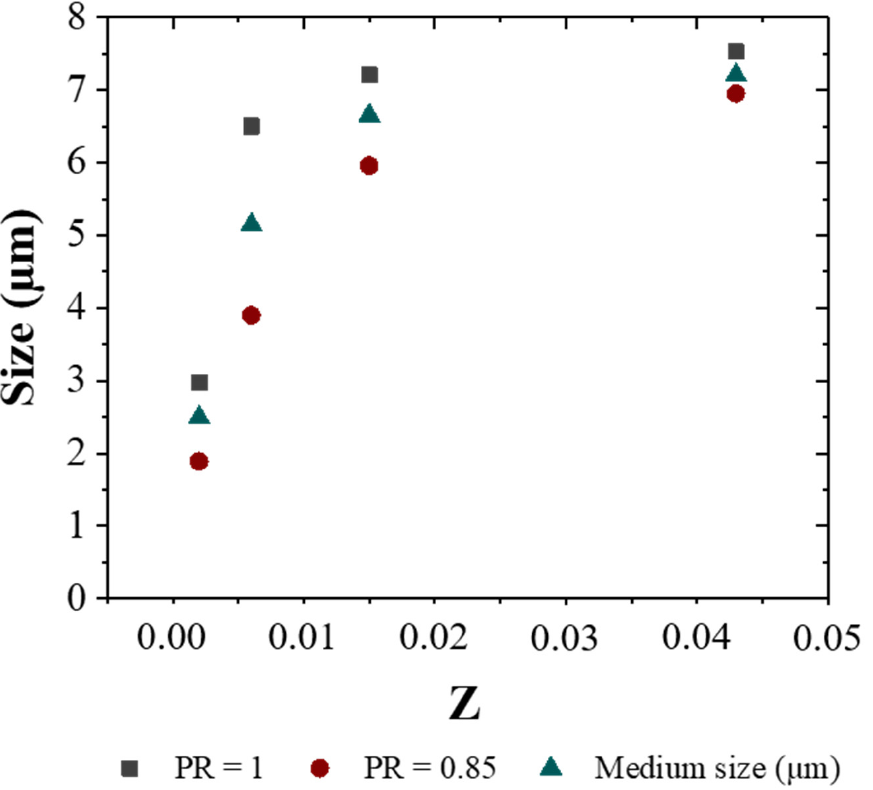
Figure 9. Influence of the Ohnesorge number on size particle.